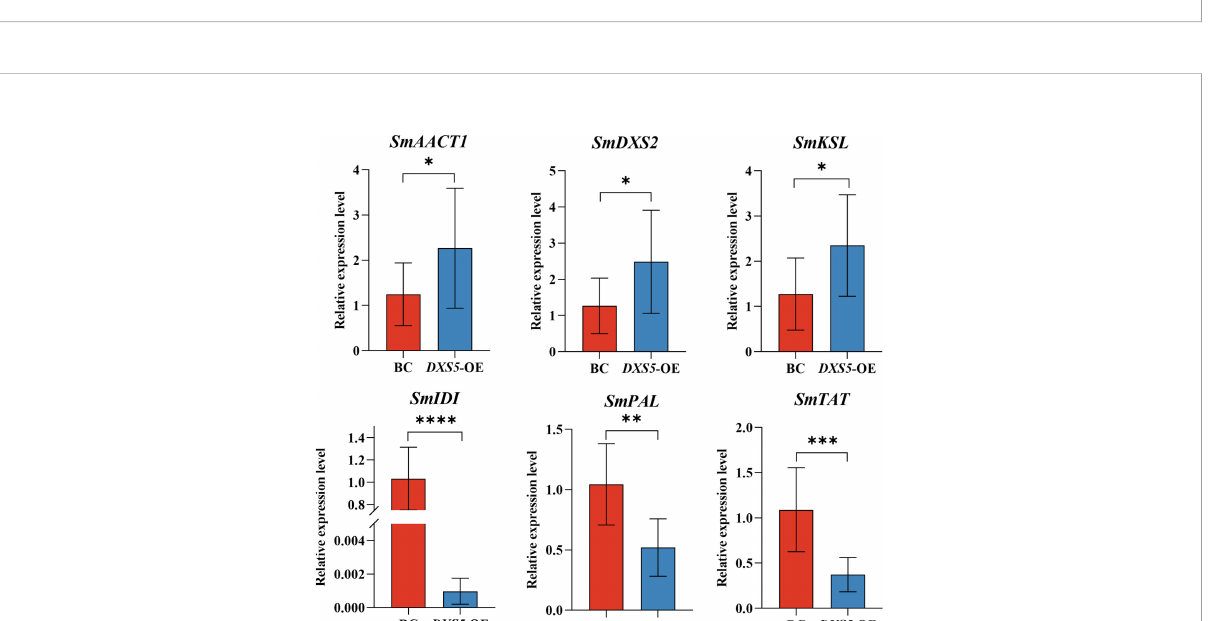
FIGURE 7 Cluster analysis of differentially expressed genes